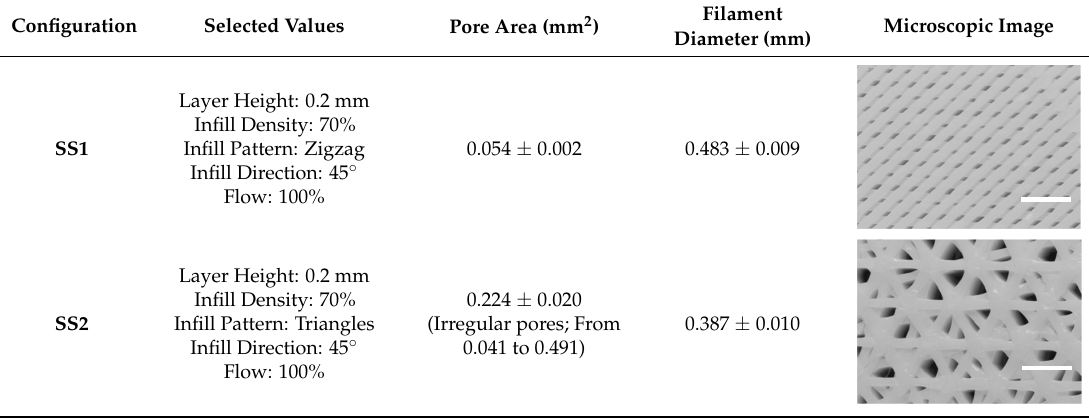
Table 3. Scaffold configurations resulting from the Taguchi experimental design analysis. (Scale bar: 2 mm).